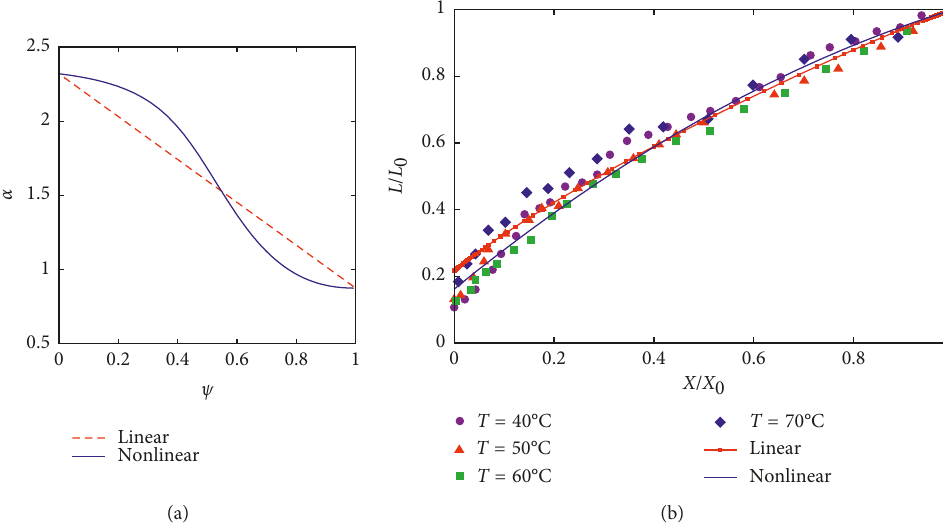
Figure 3: (a) α ψ obtained with the linear approximation X / X 0 ( ) equation (27) for chayote discoid samples. (b) Comparison between experimental data for L / L 0 vs. X / X 0 for chayote discoid samples and the 1-d moving boundary model predictions obtained with the two different models for α X / X calibration curve adopted is G 2nd 0 ) (equation (15)) and Bi m (cid:31) 2. (